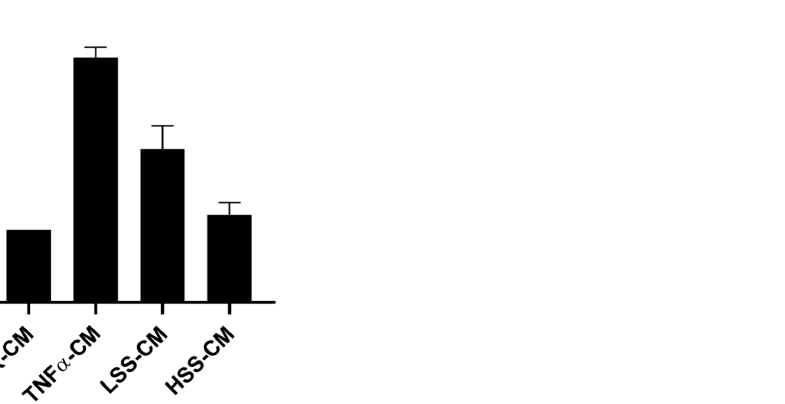
Figure 8. ICAM-1 mRNA expression in HUVECs cultured for 24 h with TNF α -, LSS- and HSS-con- ditioned media (-CMs). ICAM-1 mRNA expression is represented relative to CTR-CM (2 −ΔΔ Ct ).